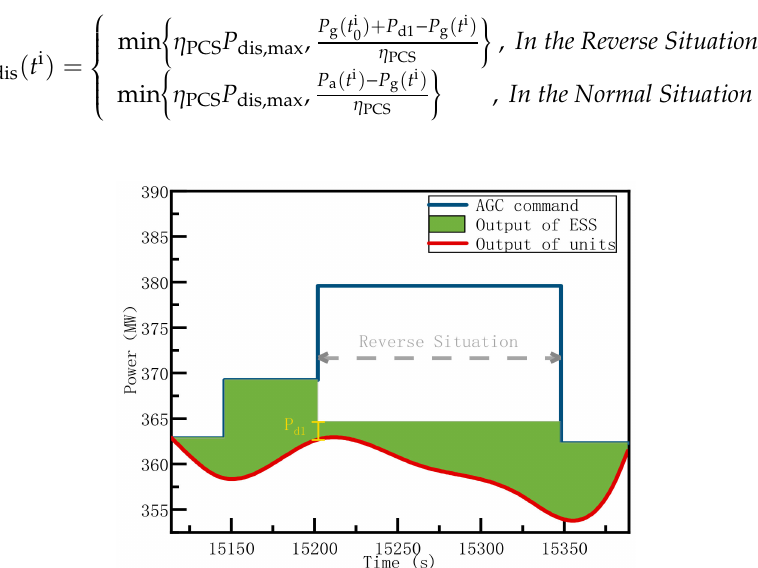
Figure 5. The strategy of ESS when the thermal power unit is in